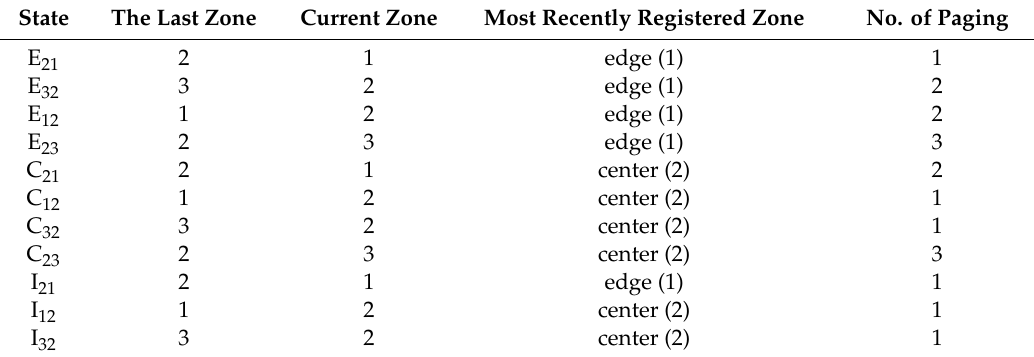
Table 1. States for the semi-Markov process model.